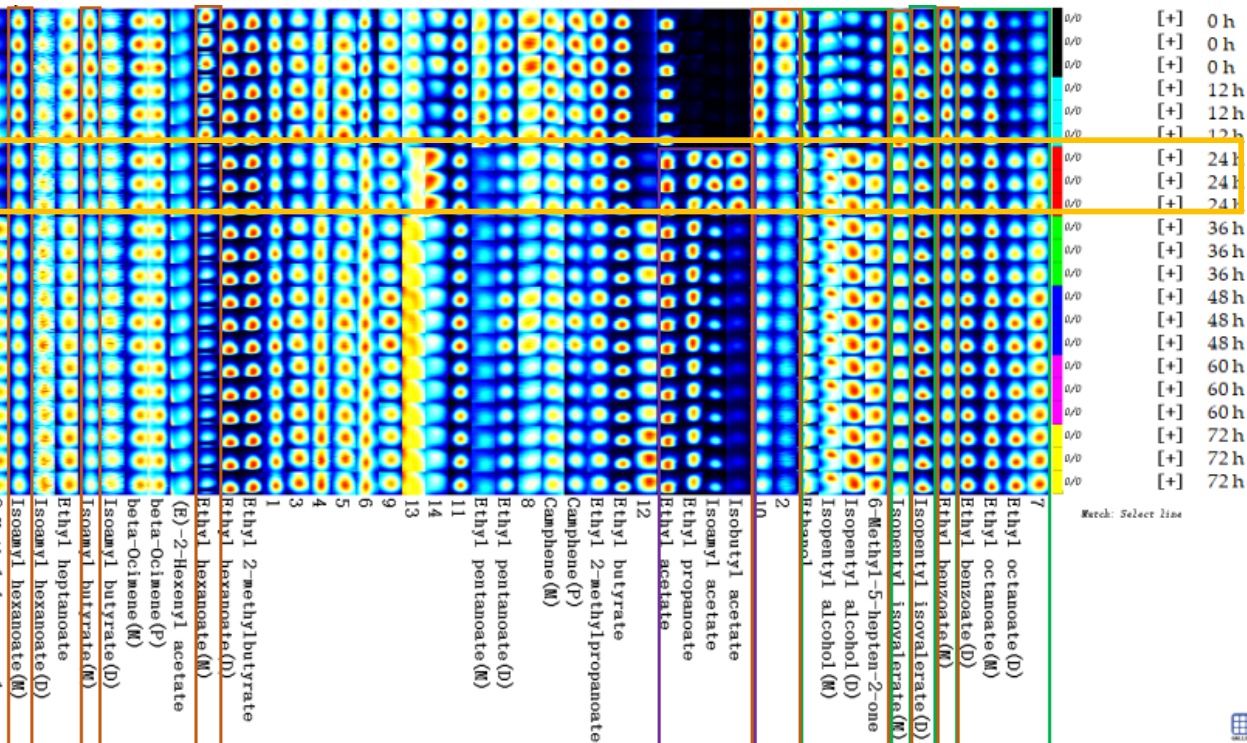
Figure 5. Changes of volatile flavor compounds during the fermentation of sea buckthorn juice by GC–IMS.